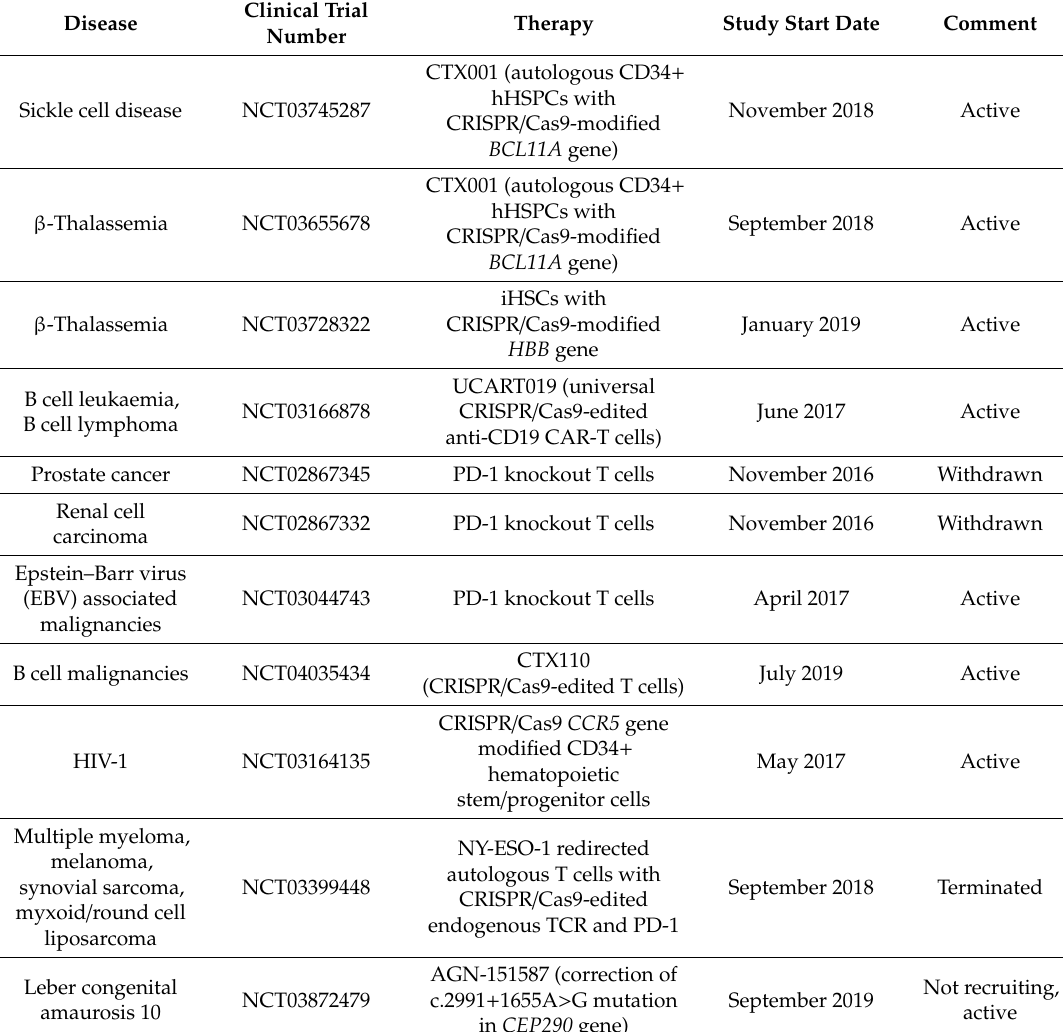
Table 2. Clinical trials of gene-editing therapies based on CRISPR / Cas9